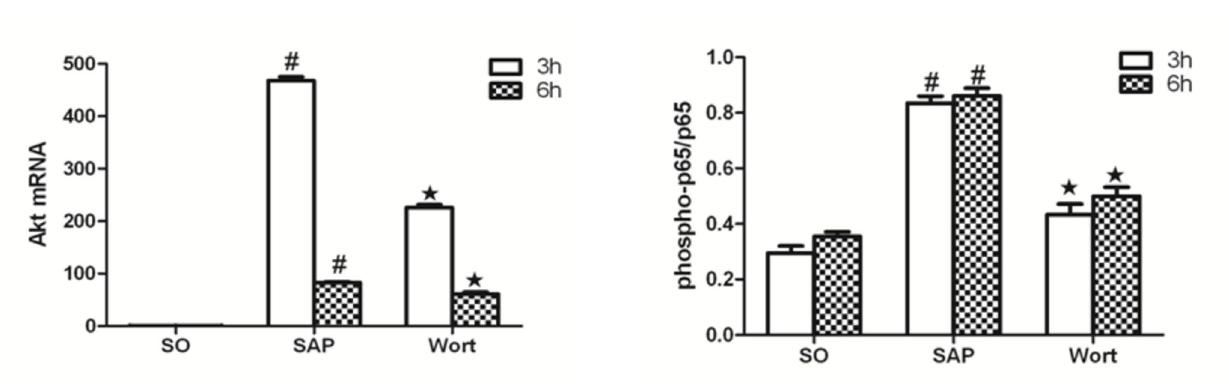
Figure 11. p-p65/p65 protein expression in each group at the 3 h and 6 h time point. # P <0.05 vs. SO group; ★ P <0.05 vs. SAP group.